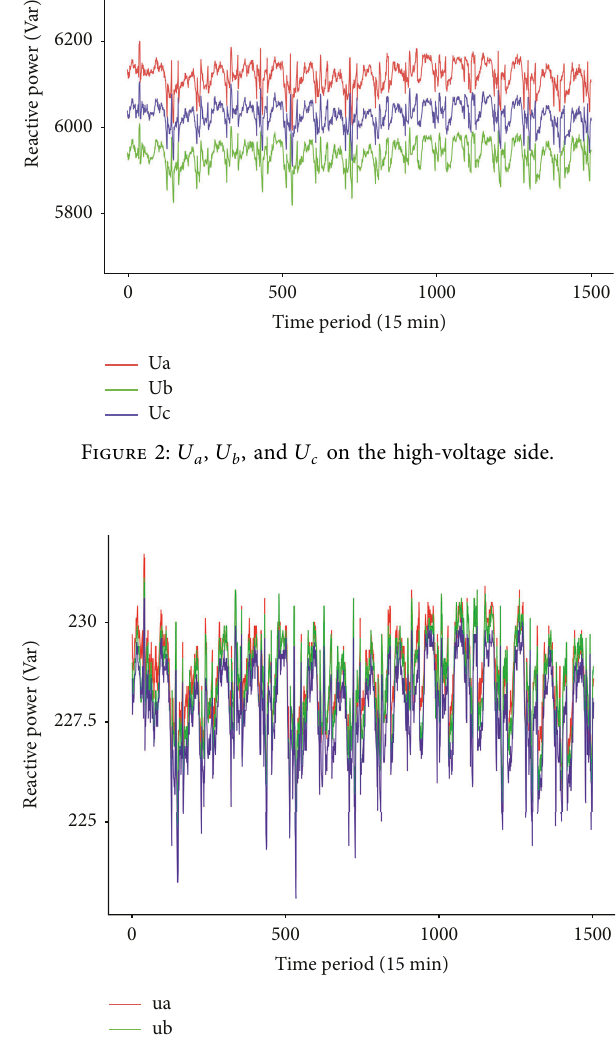
u u a , b , and c on the high-voltage